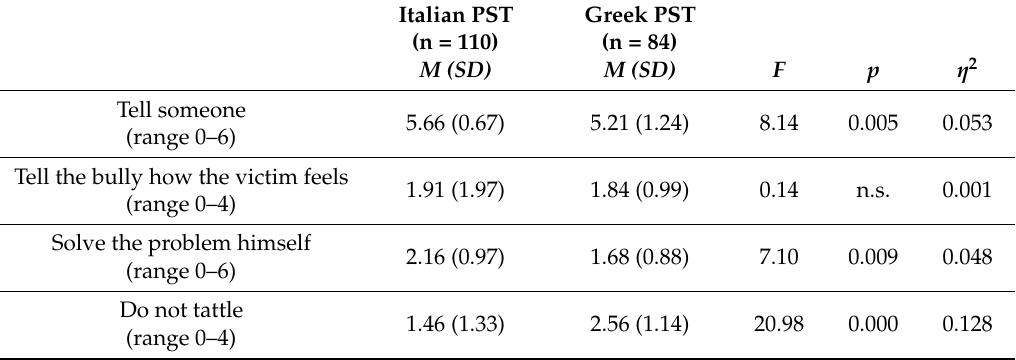
Table 3. Strategies of intervention. Comparison between Italian and Greek PST (one-way ANOVA). Italian